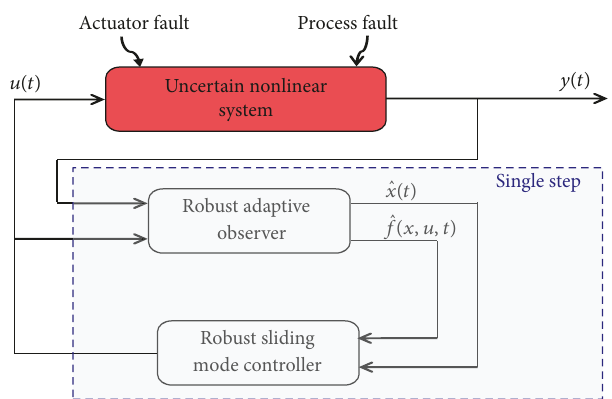
Figure 2: FE-based fault-tolerant control: an integrated